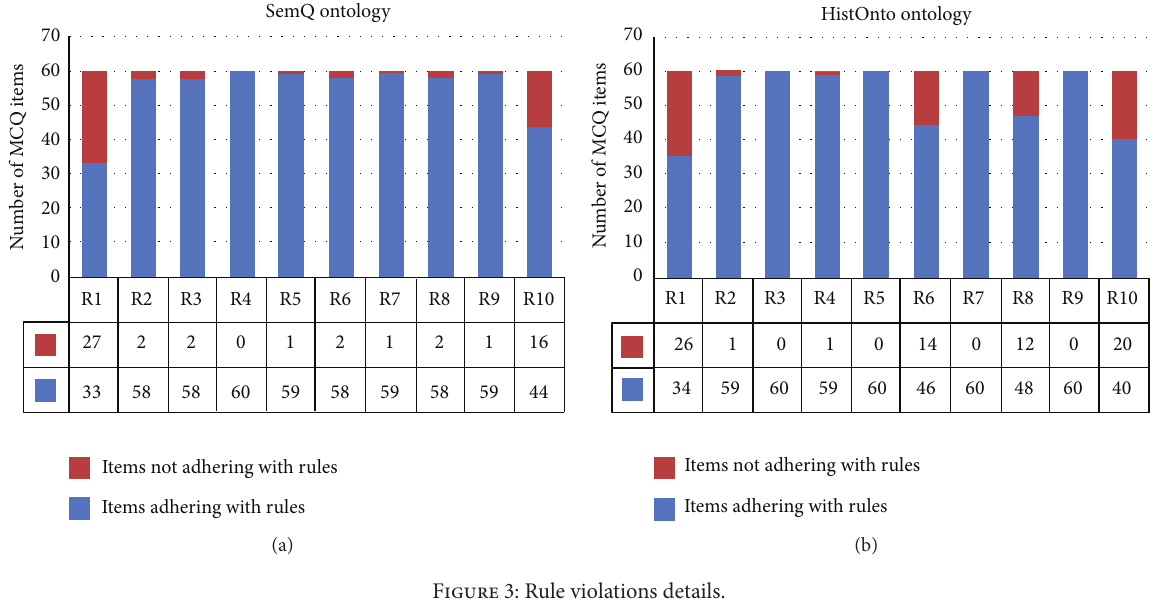
Figure 3: Rule violations